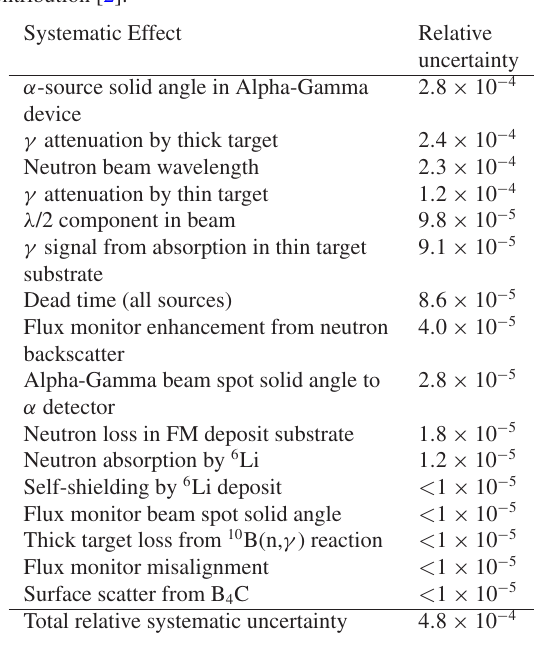
Figure 5. The BL2 proton trap and neutron flux monitor. By modulating the voltages of different numbers of electrodes, the proton trapping volume can be modified. Table 1. Systematic errors contributing to a recent BL2 flux monitor calibration campaign, from highest to lowest contribution